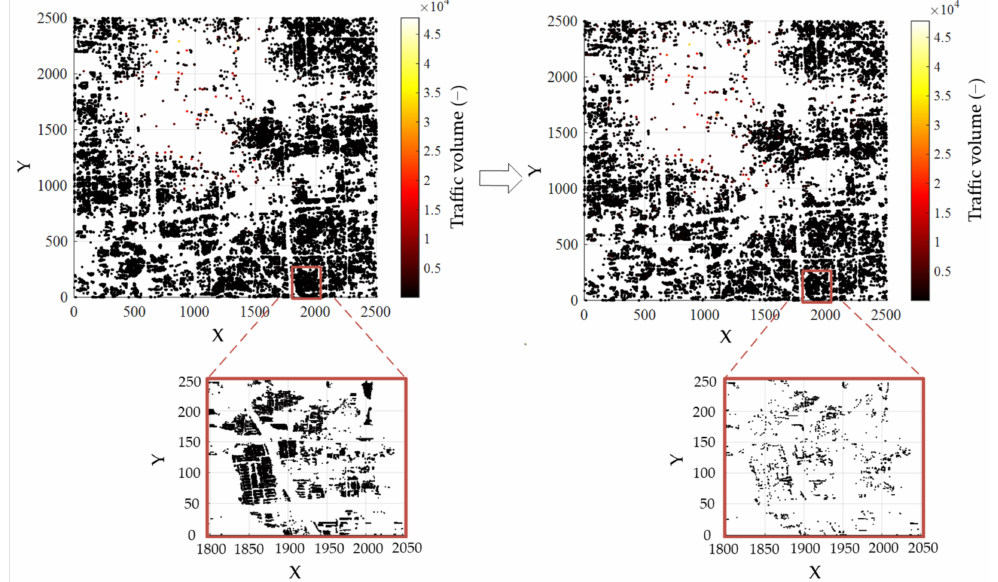
where s is the traffic volume. Visualization of the weak coverage points before and after denoising is performed, and Figure 2 is obtained.